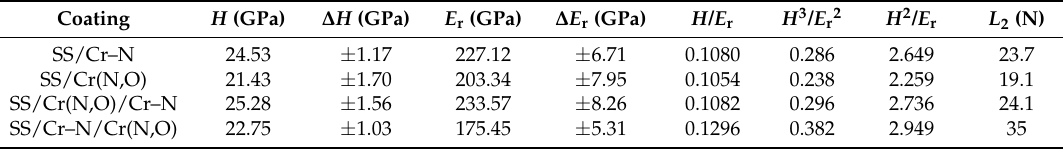
Table 3. Hardness ( H ), reduced elastic modulus ( E r ), H / E r , H 3 / E r2 , H 2 / E r ratios, and the critical loads L 2 , as determined for the Cr-based coatings deposited on 304 SS